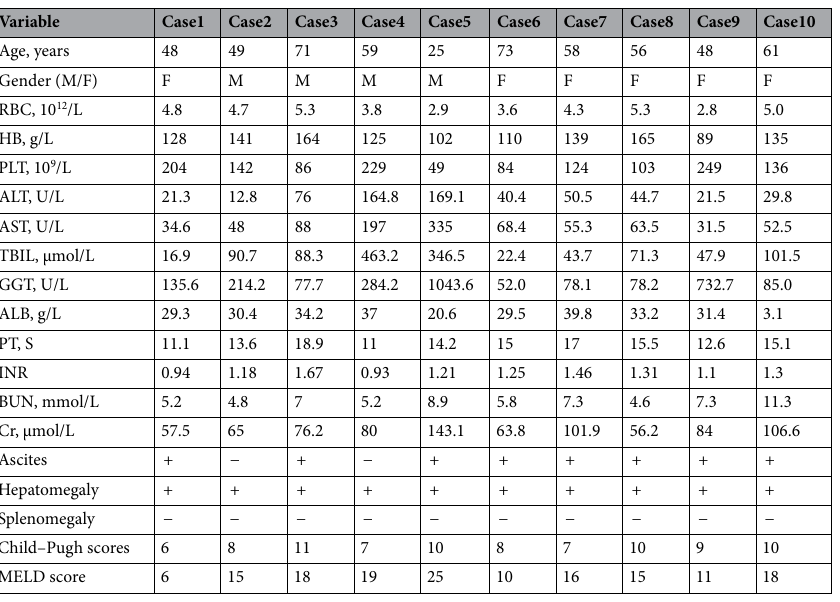
Table 1. Baseline characteristics of patients with PA-HSOS. PA-HSOS pyrrolizidine alkaloid-induced hepatic sinusoidal obstruction syndrome, F female, M male, RBC red blood cell, HB hemoglobin, PLT platelet, ALT alanine aminotransferase, AST aspartate aminotransferase, TBIL total bilirubin, GGT gamma-glutamyl transpeptidase, ALB albumin, PT prothrombin time, INR international normalized ratio, BUN blood urea nitrogen, Cr creatinine, MELD end-stage liver disease.